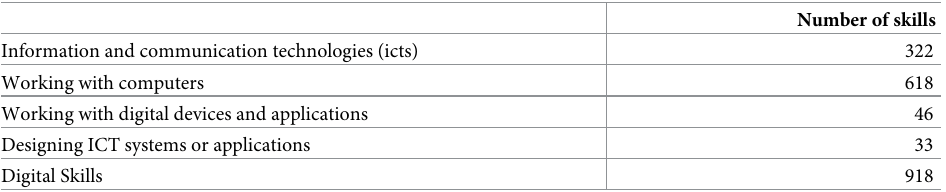
Table 1. Number of skills per digital skill